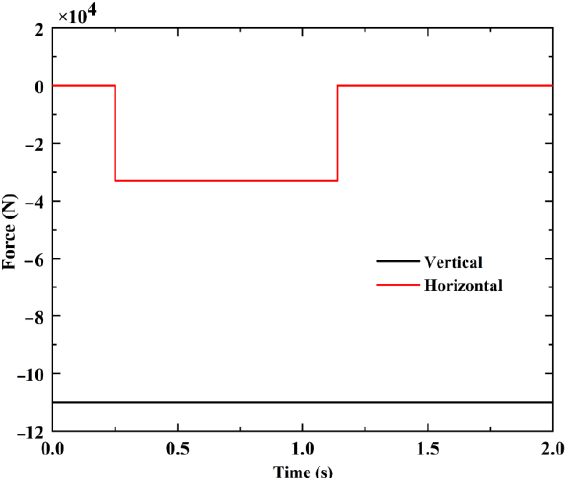
Figure 24. Diagram of equivalent surface force of superstructure.